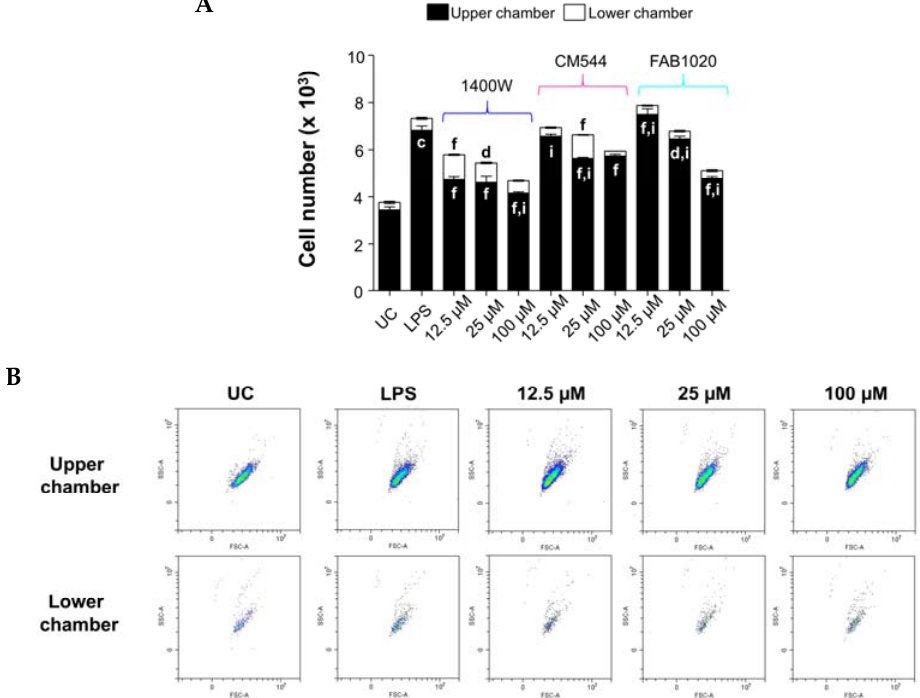
Figure 5. Cell migration in LPS ‐ stimulated human monocytes in the presence of increasing concentrations of 1400W, CM544 and FAB1020 after 24 h. ( A ) The bar graph represents the number of cells in the upper and the lower part of a Boyden chamber used for the migration assay. c = p < 0.0001 between LPS ‐ stimulated cells and untreated cells. d = p < 0.01, e = p < 0.001 and f = p < 0.0001 between LPS ‐ stimulated cells and LPS ‐ stimulated cells treated with compounds; g = p < 0.01, h = p < 0.001 and i = p < 0.0001 between LPS ‐ stimulated cells treated with 1400W and LPS ‐ stimulated cells treated with CM544 and FAB1020 at the same concentration. ( B ) Representative morphological dot plot (SSC/FSC) obtained by flow cytometry during the cell count of human monocytes in the Boyden chamber in the presence of FAB1020.